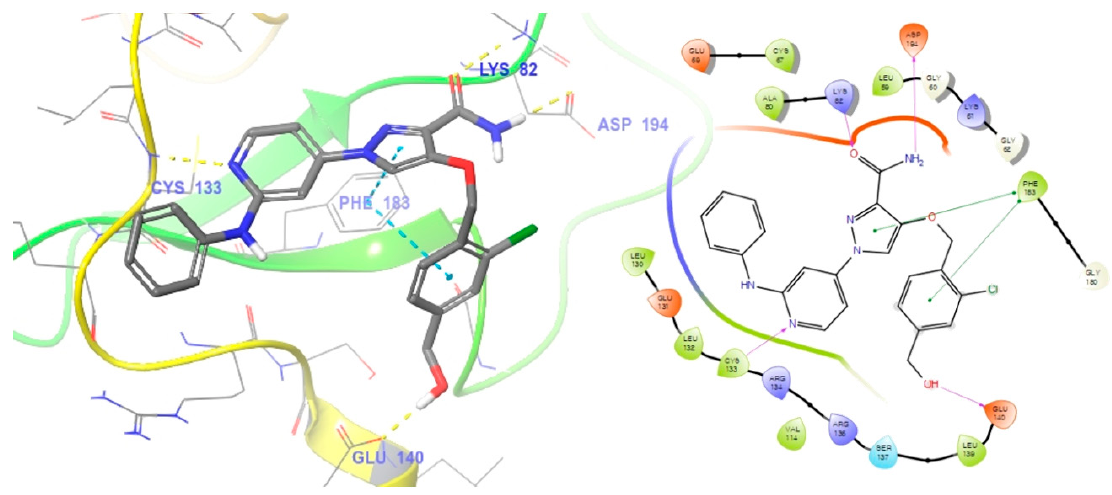
Figure 6. Docking structure of 15 at PLK1 (left, PDB: 3KB7) and the 2D-interaction map (right).